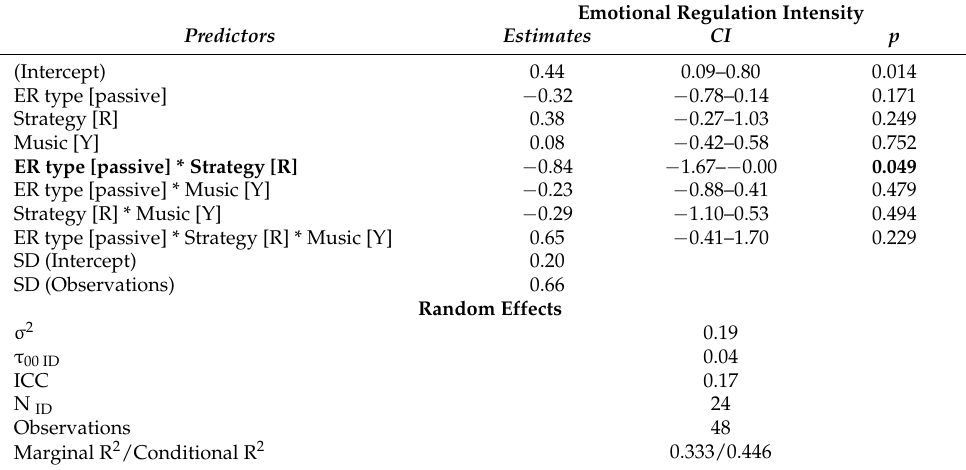
Table A2. Participants with lower musical sophistication (Gold-MSI).